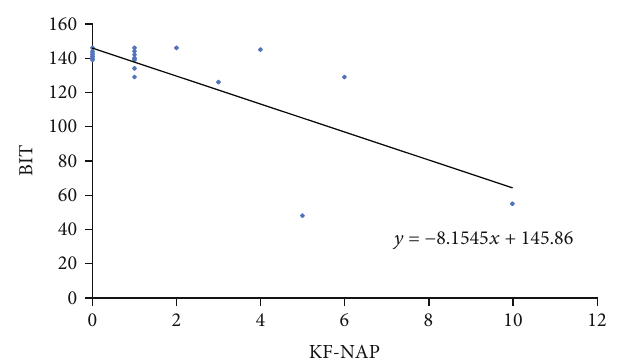
Figure 1: Correlation between KF-NAP and BIT